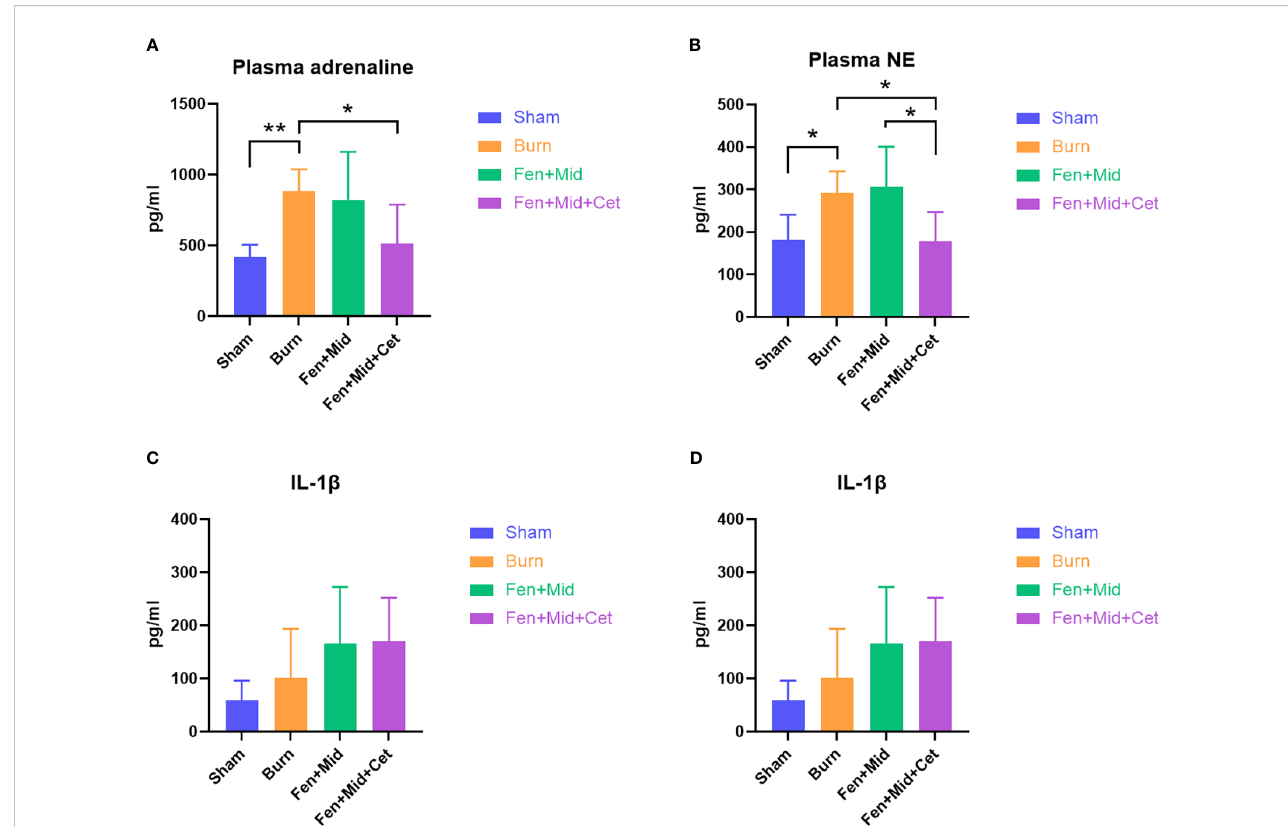
FIGURE 4 Effects of fentanyl and midazolam combined with cetirizine on plasma catecholamine levels and in fl ammatory factors in rats. The plasma adrenaline (A) , noradrenaline (NE, (B) ), IL-1 b (C) , and IL-10 (D) levels of rats in large area scald group (Burn), sham scald group (Sham), fentanyl + midazolam group (Fen+Mid), or fentanyl + midazolam + cetirizine group (Fen+Mid+Cet) were measured. n = 6, * p < 0.05, ** p < 0.01.